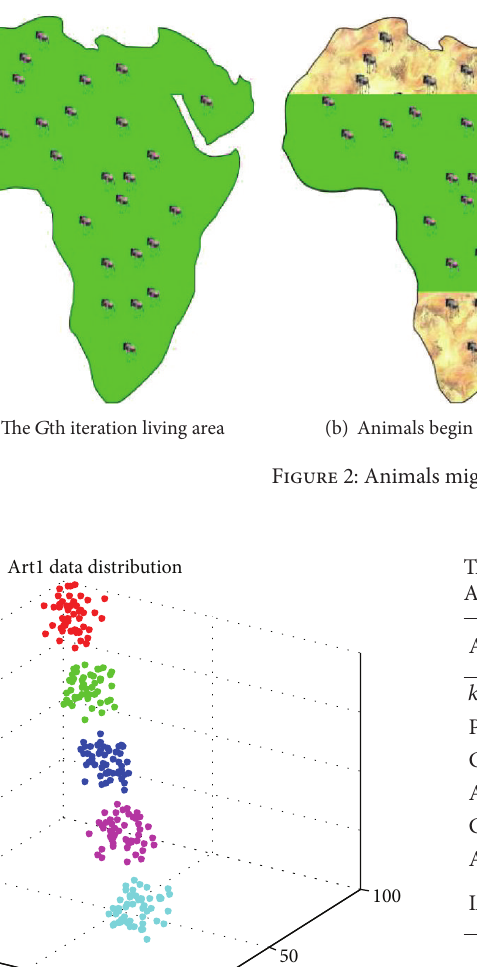
Table 2: Results obtained by the algorithms for 20 different runs